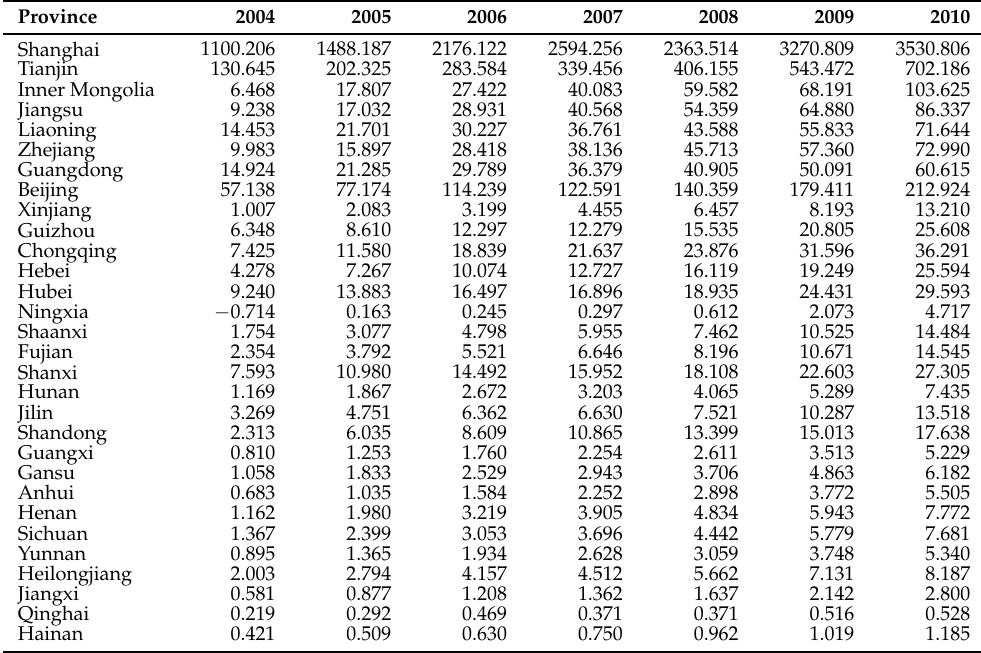
Table A3. The intra-provincial carbon inequality estimation results of original carbon emission data for 30 provinces in China from 2004 to 2010.